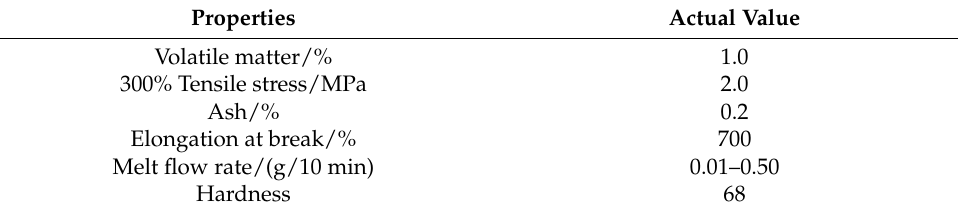
Table 3. Properties of SBS